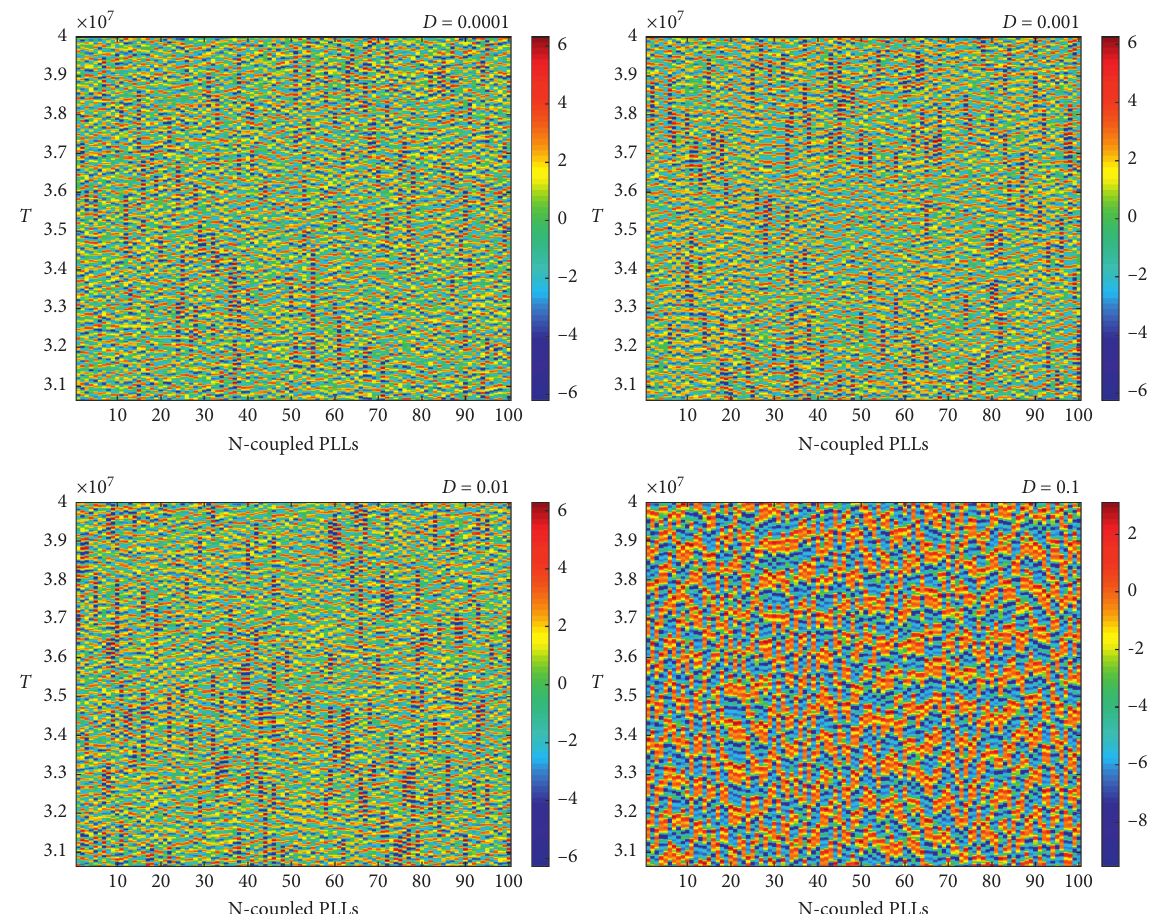
Figure 5: Spatiotemporal dynamics of the FOPLL network showing asynchronous behaviour of the FOPLL for the coupling strength 0 . 0001 ≤ D ≤ 0 . 1. We have used random initial conditions between the range [ − π , π ] for all the FOPLLs. The fractional order is fixed at q � 0 . 98 and the system parameters are fixed at K � 2 . 6 ,G �